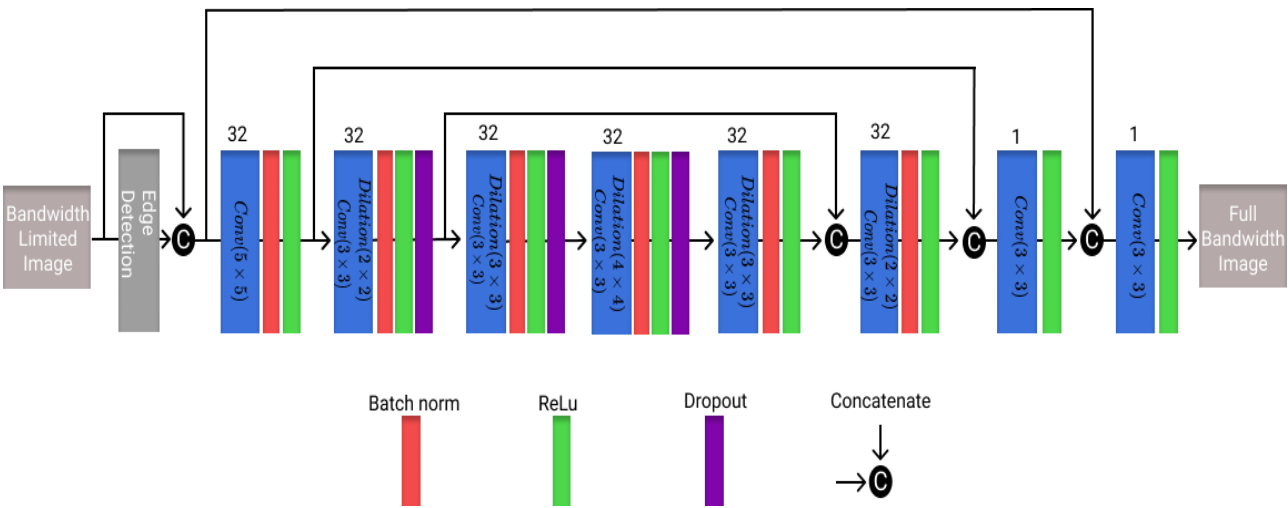
Figure 3. Visualization of the REDNet architecture utilized in this work with different blocks and the number of filters present in each